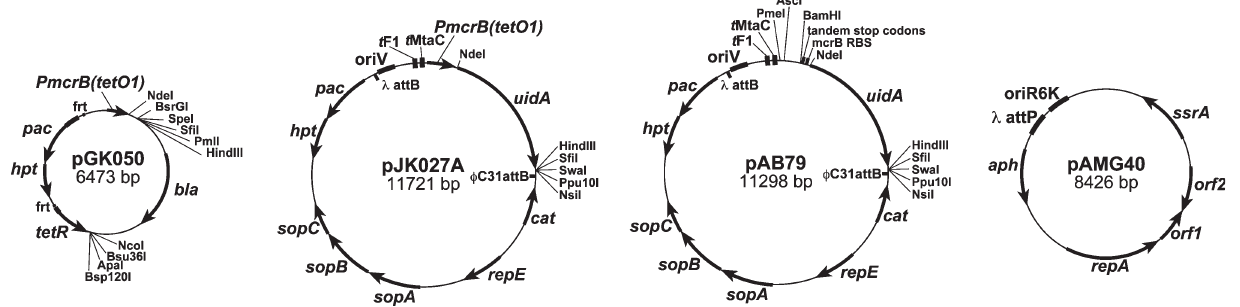
Figure 2. Structure of representative plasmids. Plasmids of the pGK050 series can be used to construct strains with Tet-dependent expression of Methanosarcina genes by “knocking in” a P mcrB( tetO ) promoterat the normal chromosomallocationof a gene of interest.To do this an appropri- ate region of homology upstream of the promoter to be deleted is cloned into one of the sites adjacent to tetR , while the gene of interest is cloned